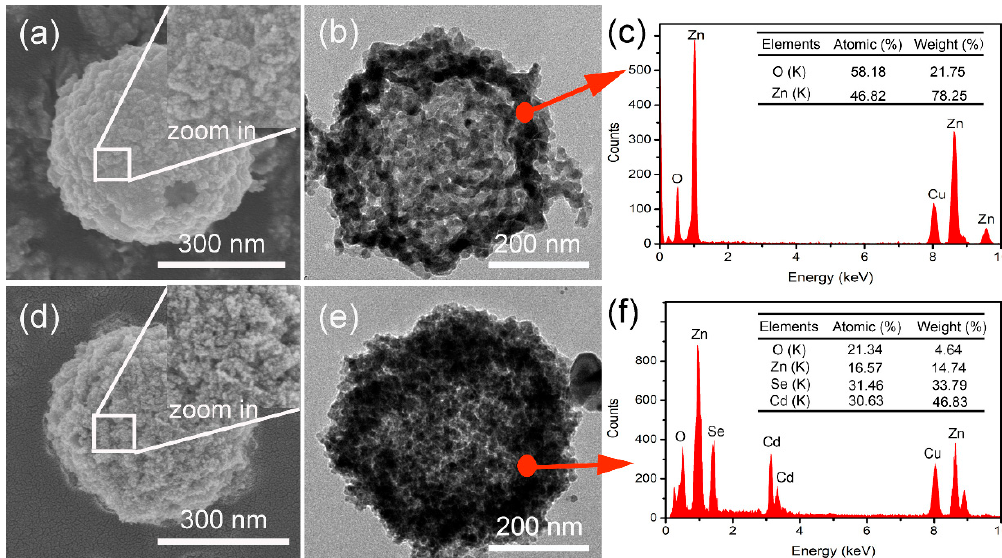
Figure 4. ( a ) SEM of ZnO HS, the inset is the magnified image of the selected zone; ( b ) TEM of ZnO HS; ( c ) energy dispersive X-ray spectrometer (EDS) of ZnO HS; ( d ) SEM of Zn x Cd 1-x Se@ZnO HS, the inset is the magnified image of the selected zone; ( e ) TEM of Zn x Cd 1-x Se@ZnO HS; ( f ) EDS of Zn x Cd 1-x Se@ZnO